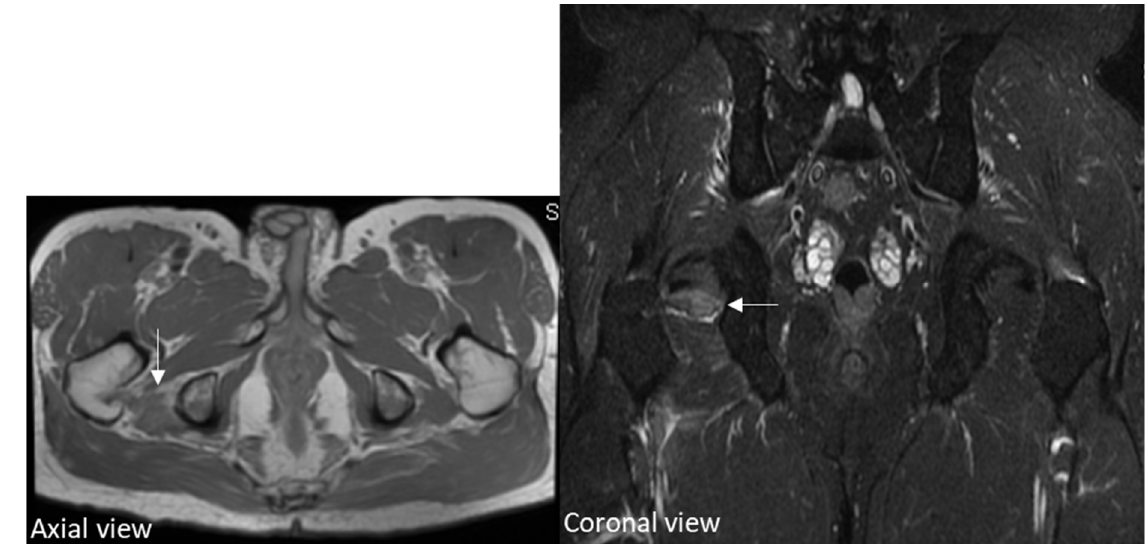
Figure 3. Coronal short tau inversion recovery images and axial proton-density weighted images of hip MRI. MRI scan demonstrated edematous change with an increased enhancement (arrow) of the right inferior gemellus muscle. Therefore, the right inferior gemellus muscle myositis was im- pressed.